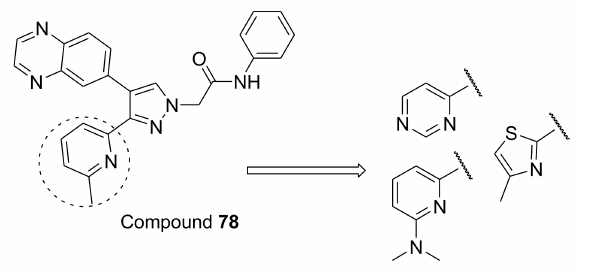
Figure 86. Schematic view showing the design strategy used to modify the o -methylpyridinyl